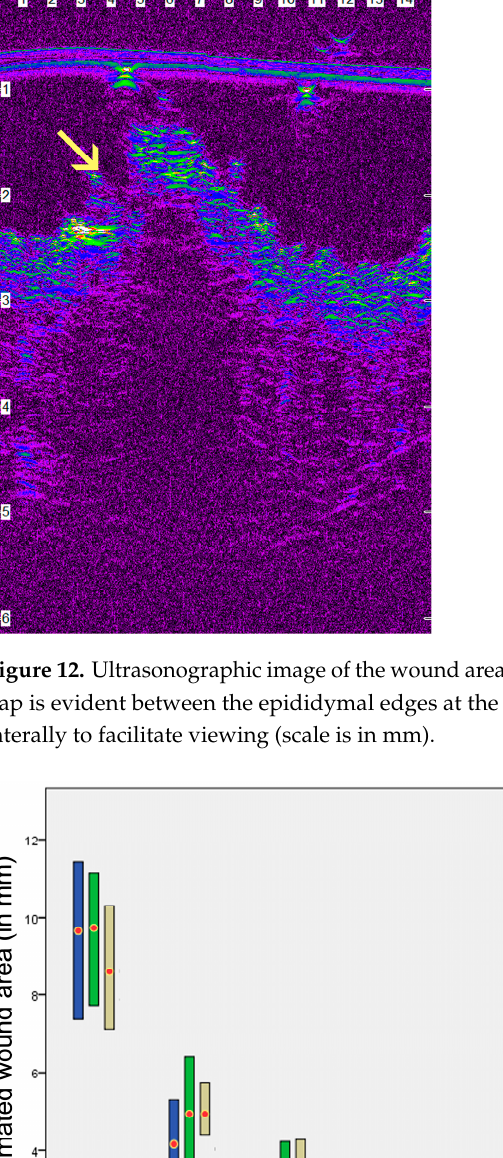
Figure 13. Median (red dot) and interquartile range (column) of u/s estimated wound area (in mm 2 ) for each technique (blue: staples, green: glue, gray: intradermal) in each period. [period A: 1–8 po.d.; period B: 9–21 po.d.; period C: 22–63 po.d.; period D: 64–180 po.d.; period E: 181–365 po.d.]. A statistically significant difference was found in periods B and C between staples and intradermal ( p = 0.007 and p = 0.006,